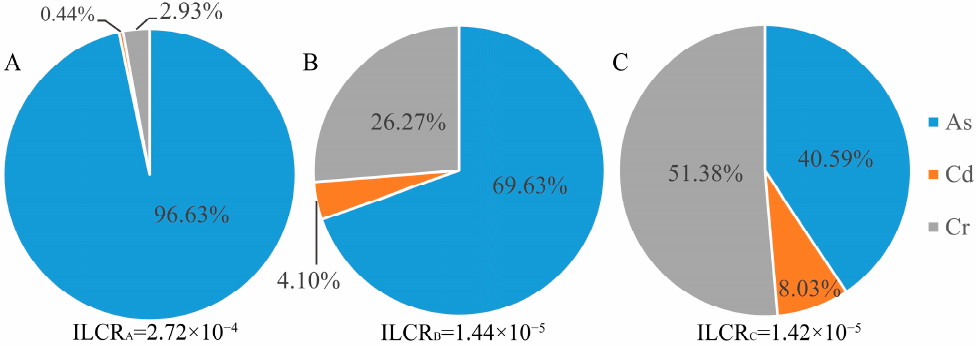
Figure 4. Noncarcinogenic risk contribution rate for oral intake of heavy metals in soil. A, B and C represent area A, area B and area C, respectively.